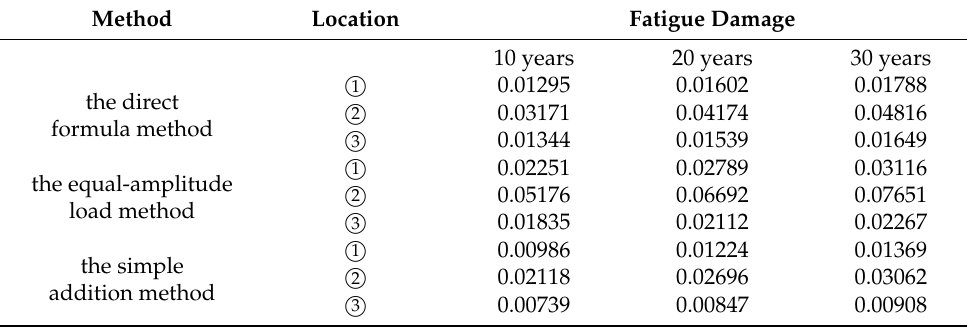
Table 5. The comparison of fatigue damage obtained by different methods.